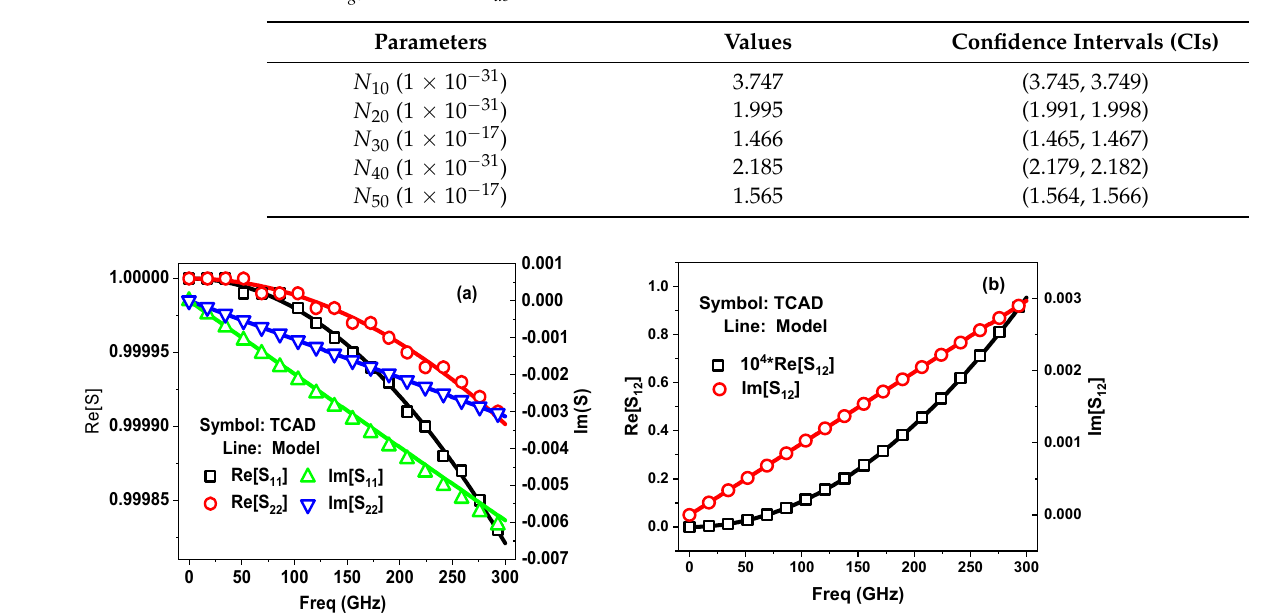
equivalent circuit simulation under a linear region ( V gs = 0.65 V, V ds = 0.05 V) and saturation region ( V gs = 0.65 V, V ds = 0.65 V) is depicted in Figure 9. Excellent agreement is obtained